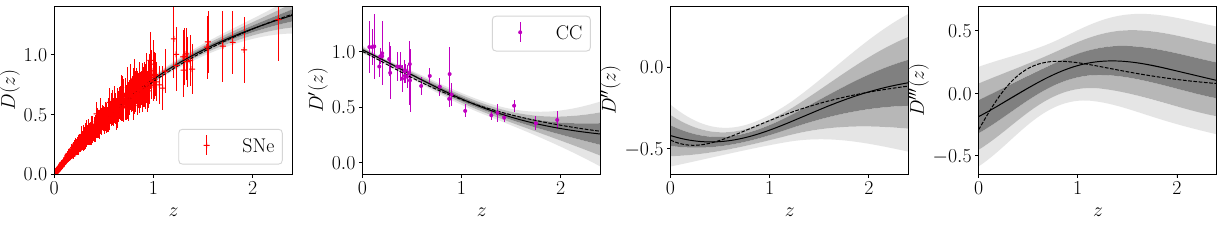
. 0 . 0 . 0 1 2 z Fig. 8 Plots for the reconstructed dimensionless co-moving luminosity distance D ( z ) , it’s derivatives D (cid:3) ( z ) , D (cid:3)(cid:3) ( z ) and D (cid:3)(cid:3)(cid:3) ( z ) using combined Pantheon + CC + BAO + CMB data. The black solid line is the best fit curve. The associated 1 σ , 2 σ and 3 σ confidence regions are shown in lighter shades. The specific points (in the top two figures) with error bars represent the observational data. The black dashed line is for the (cid:2) CDM model: (cid:12) = 0 . 3 m 0 fidence levels (CL). The black solid lines show the “best fit” values of the reconstructed function, and the black dashed lines corresponds to the (cid:2) CDM model with (cid:12) m 0 = 0 . 3 and j = 1. The plot shows that the (cid:2) CDM model, is allowed within a 2 σ error bar. Plots for the “best fit value” of the jerk parameter clearly indicate that j has an evolution, and also, this evolution may well be non-monotonic. The recon- structed best fit q 0 and j 0 at the present epoch is shown